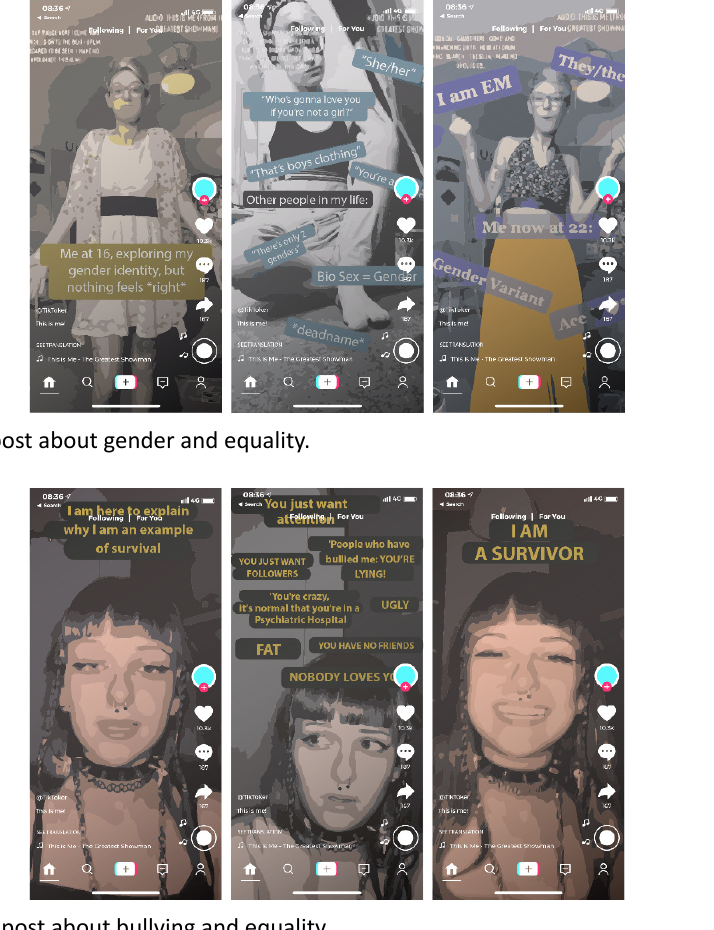
Figure 10. Illustrated TikTok post about bullying and